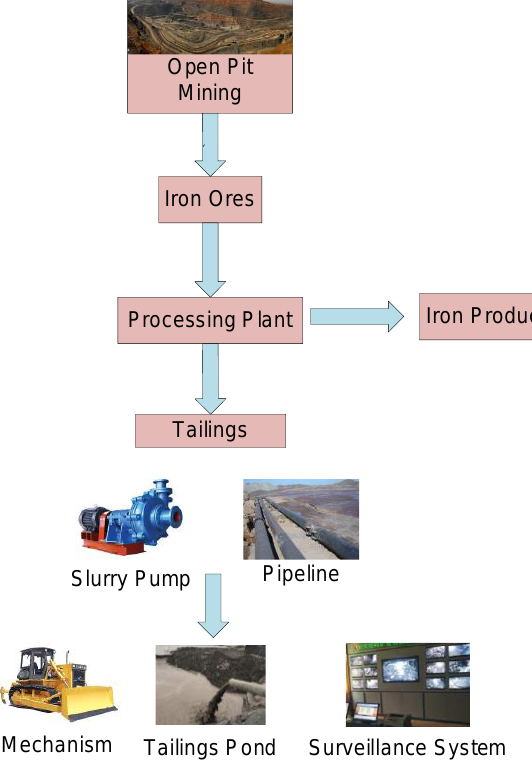
Figure 1. Flowchart of conventional slurry disposal technology (CSDT).